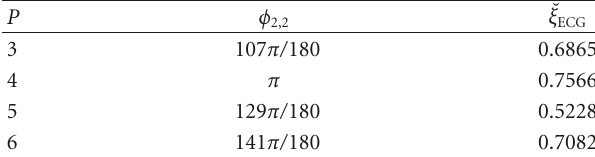
Table 2: Optimal rotation angle for COST207.